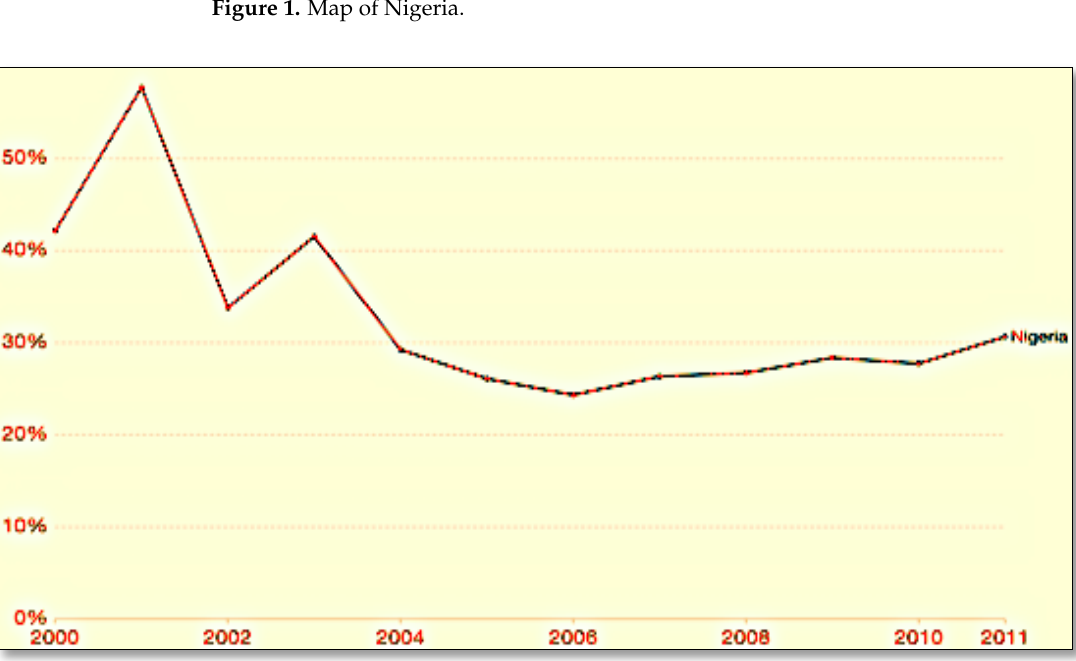
Figure 1. Map of Nigeria.